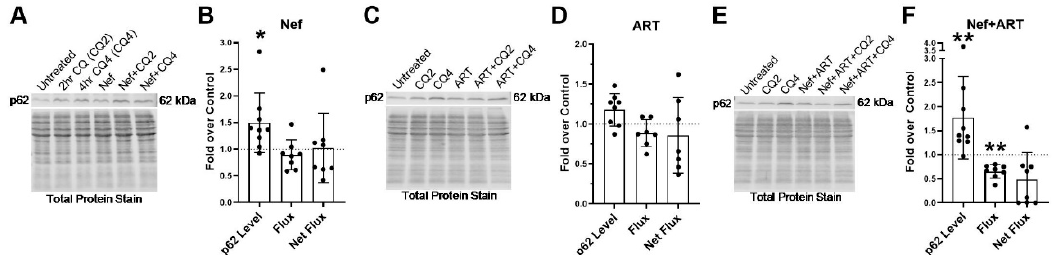
Figure 5. p62 lysosomal degradation after treatment with Nef and / or ART for 24 h. Primary human astrocytes were treated with extracellular Nef and / or ART for 24 h, without and with chloroquine (CQ) for the last 2 or 4 h, after which p62 Western blotting was performed. Steady-state level, flux and net flux for p62 were calculated as described in Methods. ( A , C , E ) Representative p62 Western blots after A. Nef, C. ART, or E. Nef + ART treatment. ( B , D , F ) show the fold changes of autophagy parameters after B. Nef, D. ART, and F. Nef + ART treatment over control of individual experiments (dots) and the means of the fold changes of the experiments (bars). Controls were set to 1, represented by the dashed lines. Error bars depict SD. n = 7–9; *, p < 0.05; **, p < 0.005 by the Wilcoxon Signed Rank test.